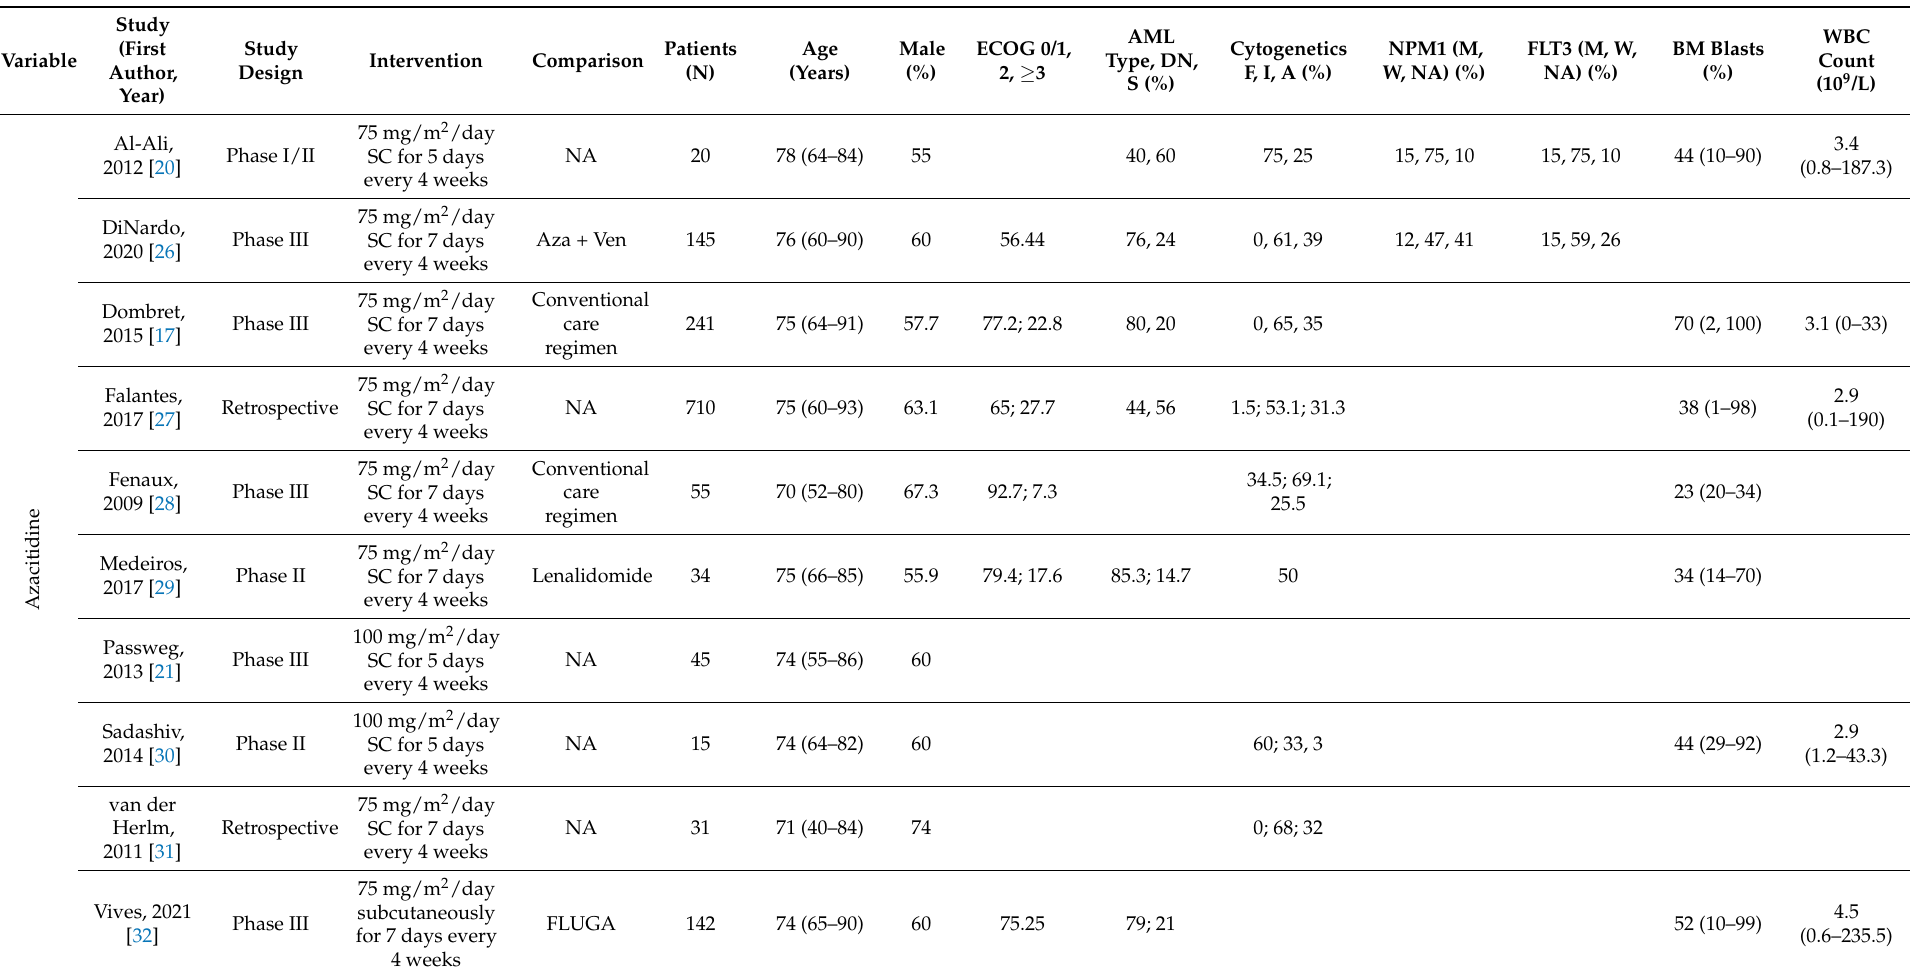
Table 1. Patient characteristics of studies included in the